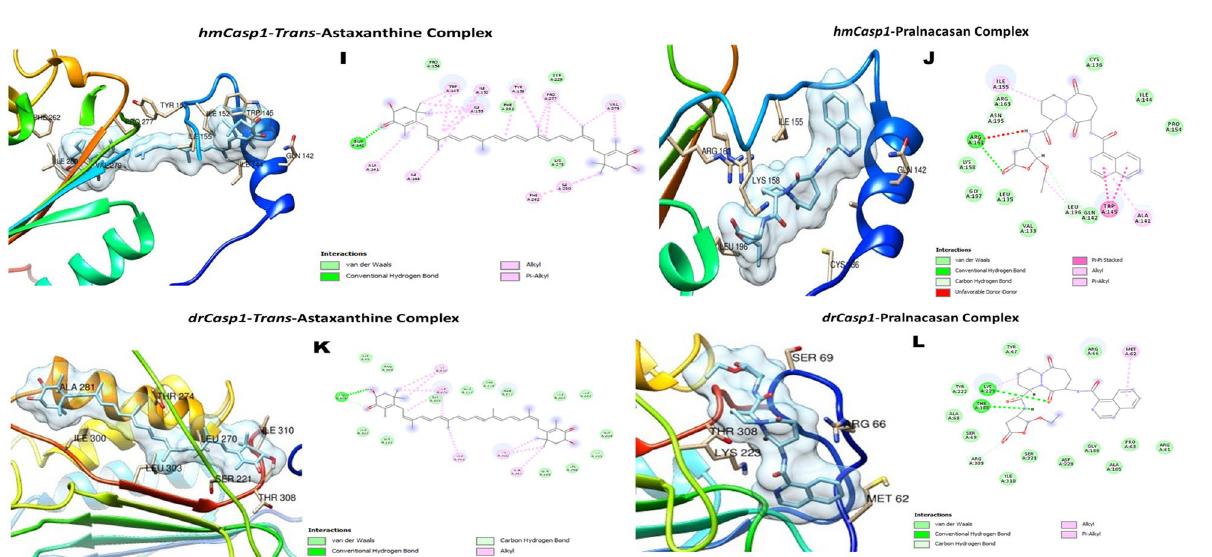
Figure 8. The 3D and 2D molecular complexations of Human Caspase-1 (hmCasp-1) with TA ( I ) and Pralnacasan ( J ); and Drosophila Caspase-1 (drCasp-1) with TA ( K ) and Pralnacasan ( L )